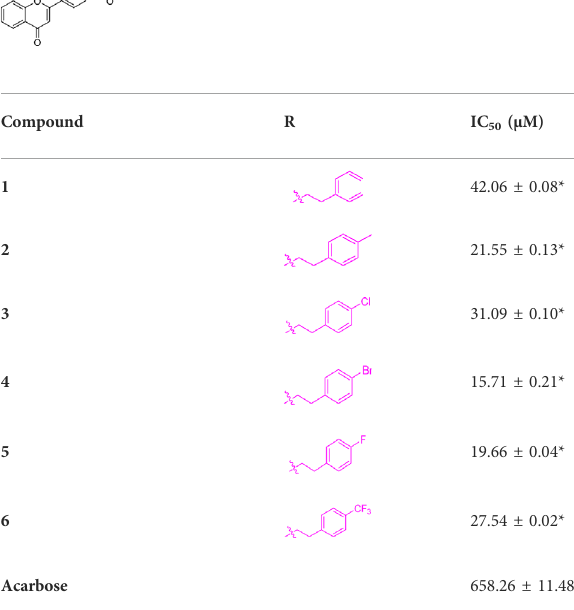
TABLE 1 The anti- α -glucosidase activity of fl avonoid derivatives.